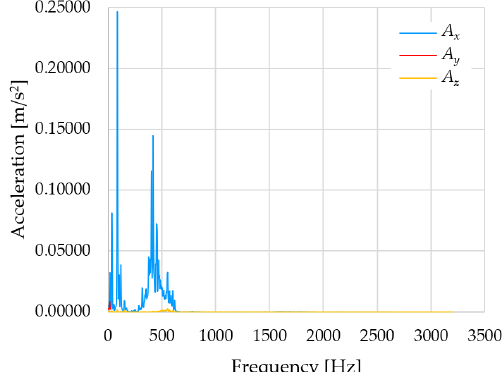
Figure 10. Acceleration progress depending on frequency in X- , Y- and Z -axes for velocity 60% (78.6°/s).